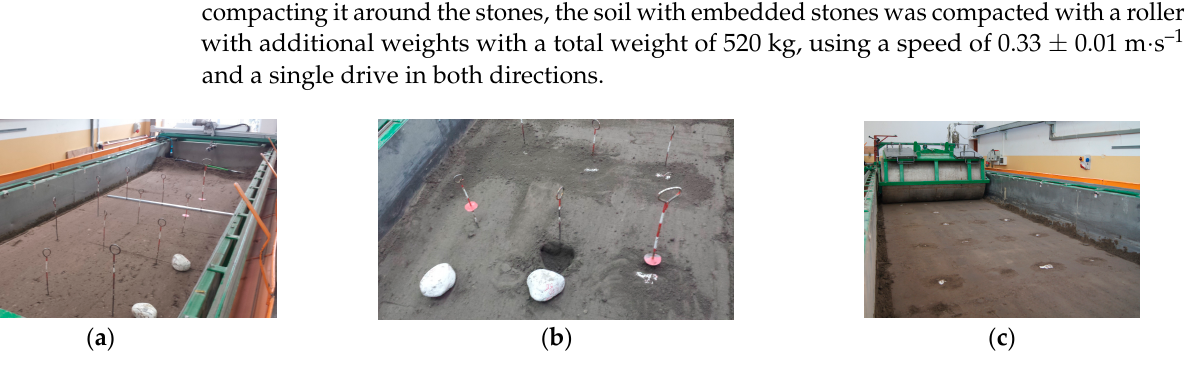
Figure 5. Procedure for placing stones: ( a ) planned grid for the placement of stones, ( b ) preparing a hole in the shape of a stone and placing the stones in the soil, ( c ) compaction of soil with stones.